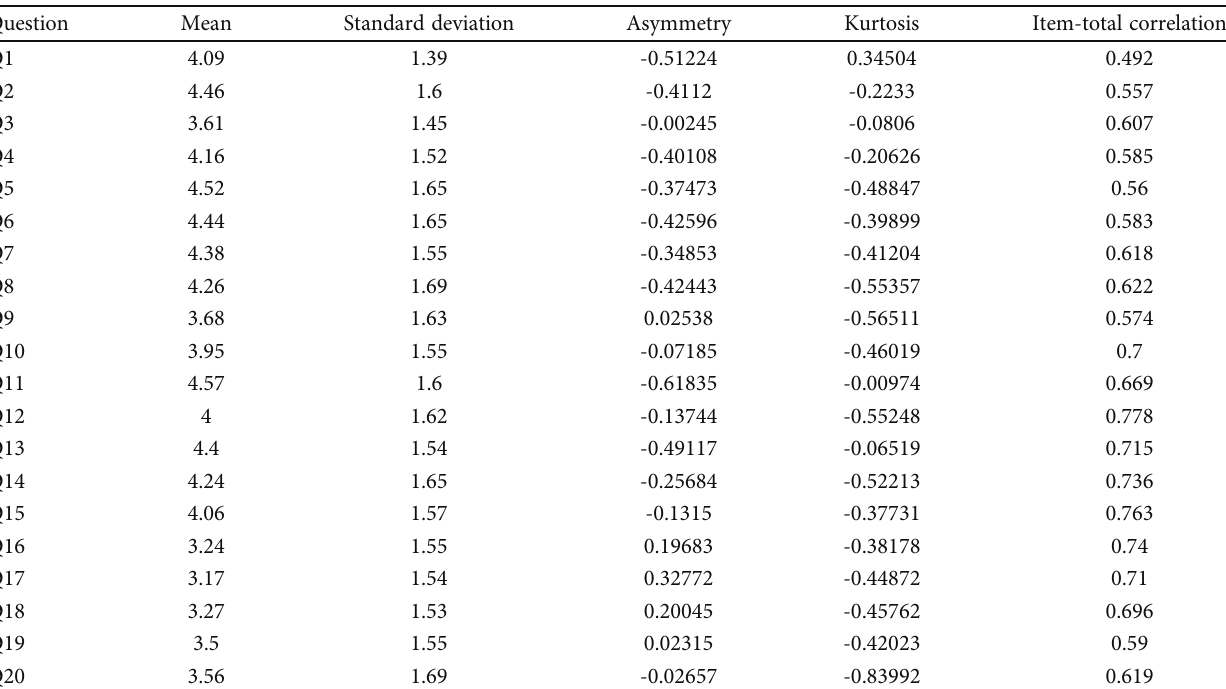
Table 5: Characterisation of the sample data.